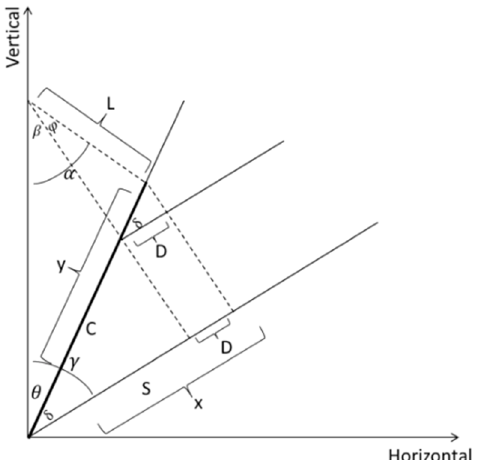
Figure 7. Acquisition geometry of the S1 and CSK satellites used to project the vertical component of deformation of the S1 dataset onto the CSK line of sight. It is worth remarking that even though the ENV LOS is not present in this figure, the same approach has been applied to such dataset considering the proper incidence angle, i.e., equal to the standard acquisition off-nadir of 23°.